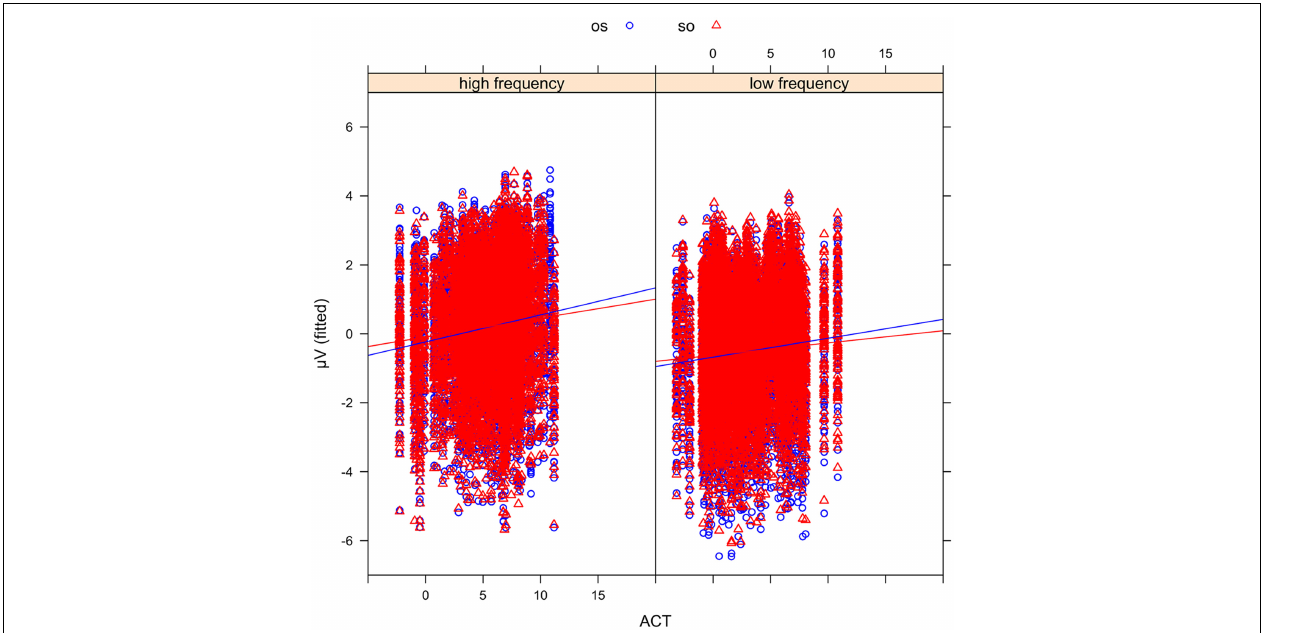
nouns with a low ACT value. Note that this figure also demonstrates the correspondence between the mixed model fits and the observed ERP pattern: the N400 amplitude difference for low versus high FRQ nouns (see Figure 4 ) is reflected here in the generally more negative amplitudes for low FRQ nouns (right panel) than their high FRQ counterparts (left panel)